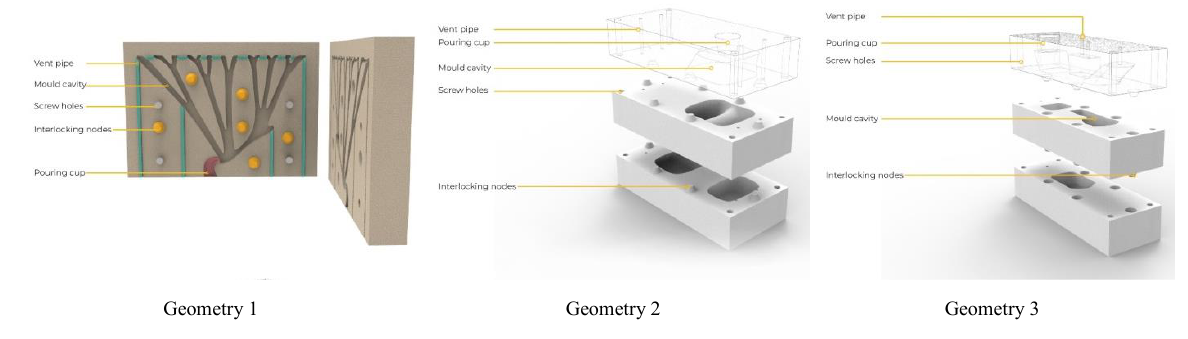
Fig. 7 Designed mould